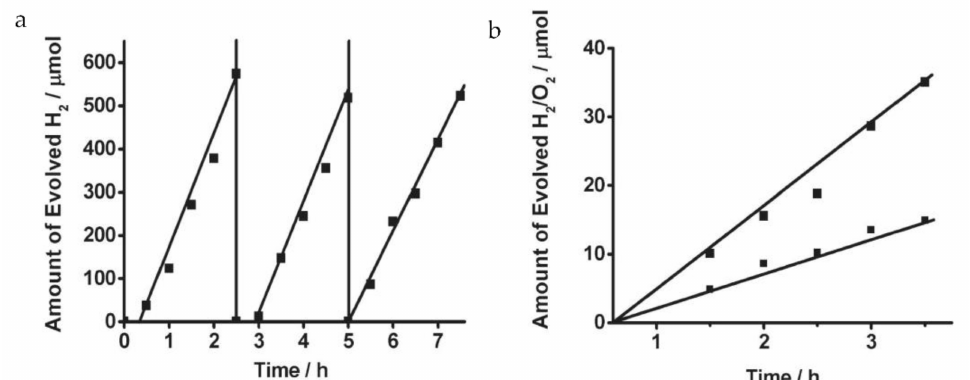
Figure 7. ( a ) Time course of H 2 evolution from 100 mg of 0.5% Pt loaded photocatalyst 2 under UV irradiation in 270 mL of 20% methanol aqueous solution. ( b ) Time course of overall water splitting from 50 mg of 0.5% NiO-loaded photocatalyst 2 under UV irradiation in 270mL of pure water. Reprinted with permission from [93]. Copyright (2011) American Chemical